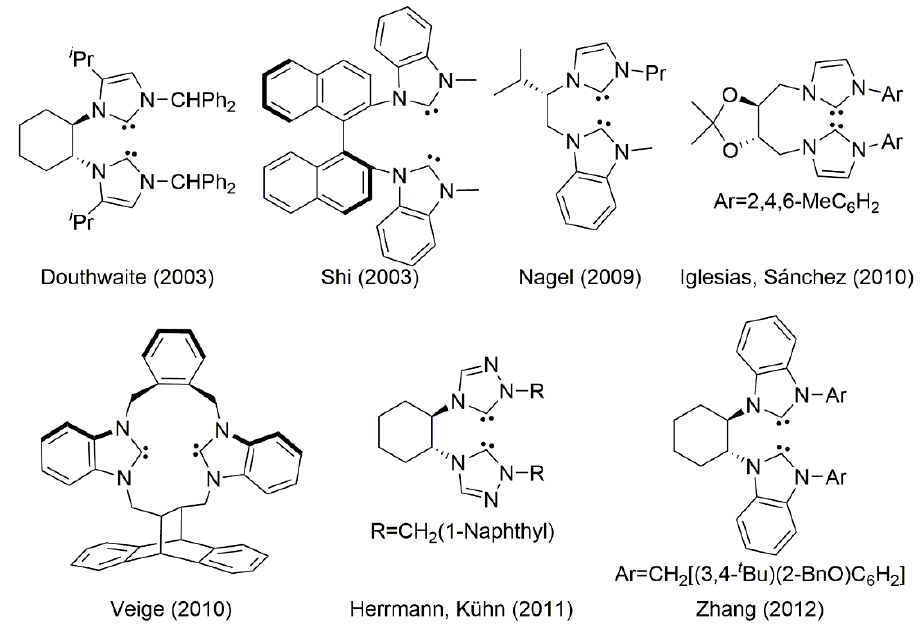
Figure 1. Selected examples of chiral bis- N -heterocyclic carbenes bis(NHC)s.